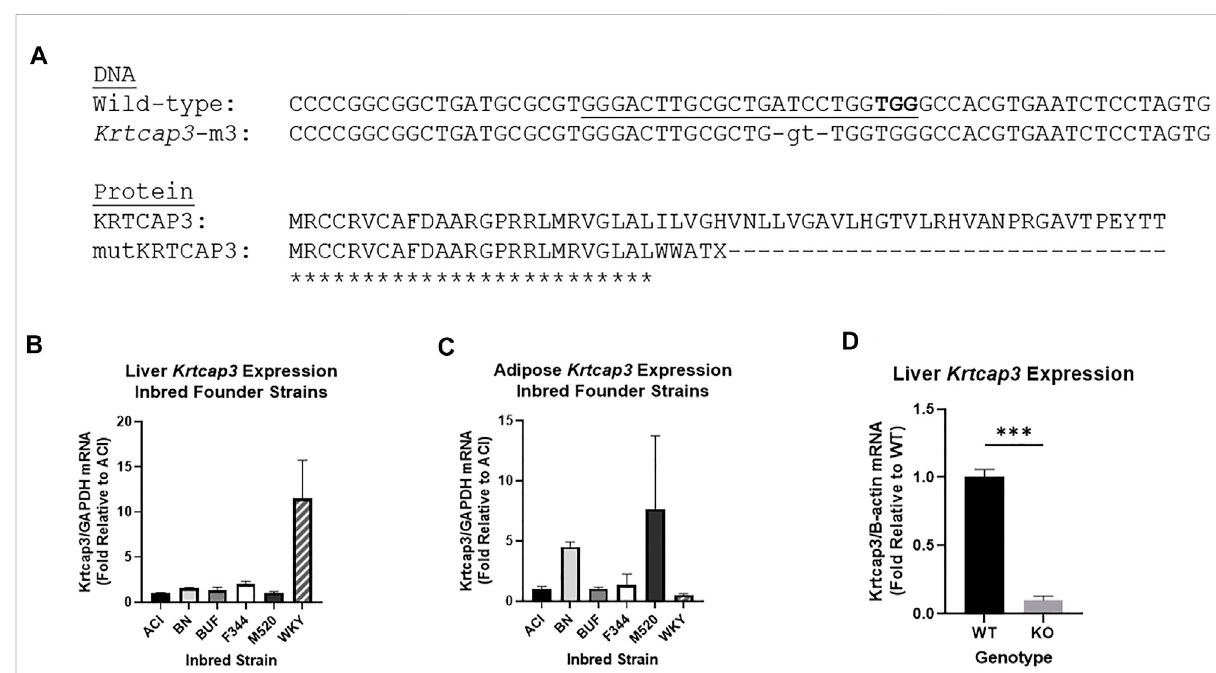
FIGURE 1 Development and con fi rmation of Krtcap3 knock-out (KO) rats and tissue expression analyses. (A) CRISPR-Cas9 mutagenesis was used to target the second exon (underlined sequence, protospacer adjacent motif in bold), resulting in a 4 base-pair deletion and 2-based pair insertion (lowercase).Thisresultsinapredictedframeshiftafter25aminoacidsandprematureterminationofthenormalproteinsequence(onlythe fi rst60of 240 amino acids shown). Asterisks indicate identical amino acids. (B) RNA was extracted from liver tissue of available HS inbred founder strains to compare Krtcap3 expression. Available strains areACI/Eur,BN/SsHsd, F344/NHsd, M520/NMcwi,WKY/NHsd. Fold changewas calculated relative to ACI Krtcap3 expression. (C) RNA was extracted from retroperitoneal adipose tissue of the same inbred founder strains to compare Krtcap3 expression.FoldchangewascalculatedrelativetoACI Krtcap3 expression. (D) RNAwasextractedfromlivertissueofadolescentWKYwild-type(WT) and KO rats ( n = 3 per genotype, mixed sex) and Krtcap3 expression analyzed to assess the success of the Krtcap3 -KO. Fold change was calculated relative to WT Krtcap3 expression. *** p <